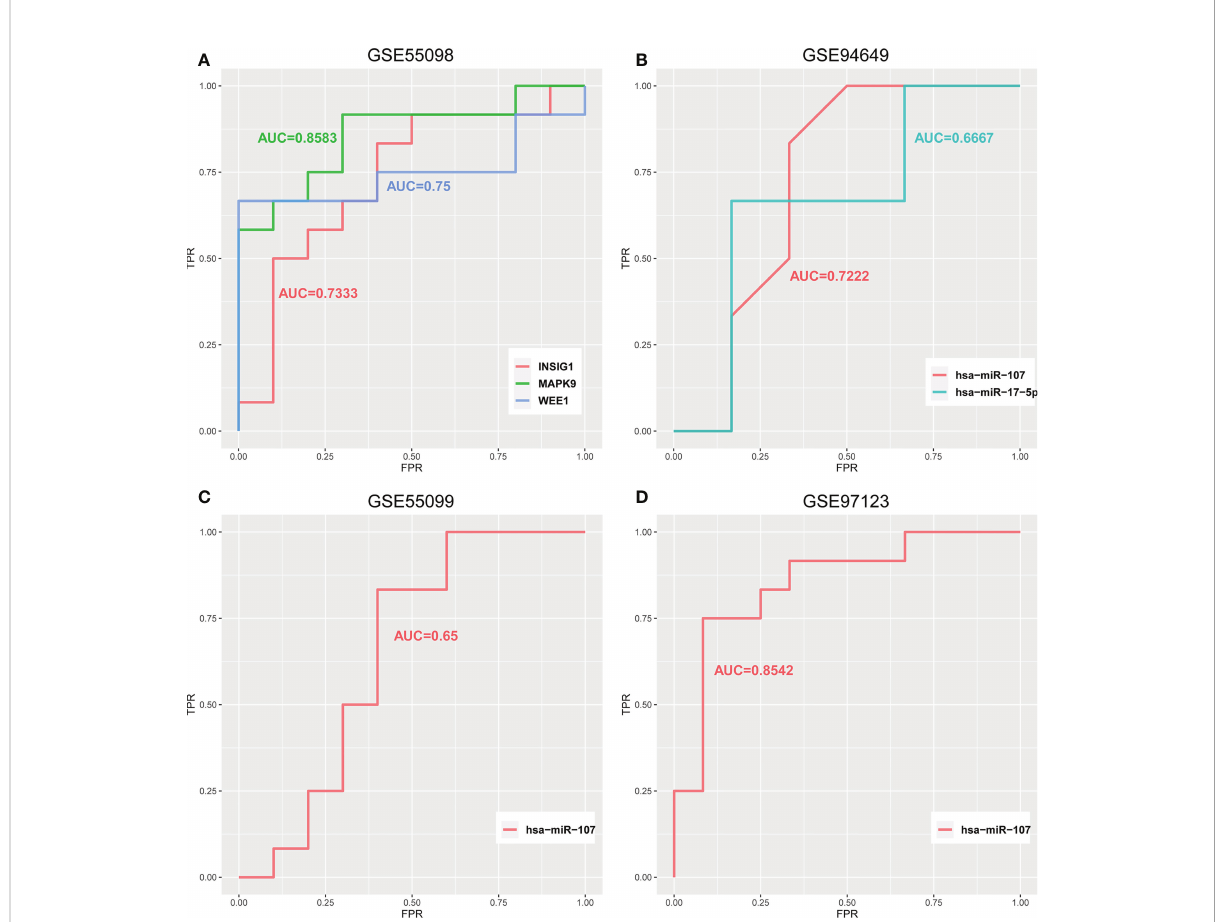
FIGURE 8 ROC curves for classifying type 1 diabetes samples of (A) GSE55098 based on the expression of LINC02086-hsa-miR-17-5p-MAPK9/WEE1 and LINC00960-hsa-miR-107-INSIG. (B) GSE94649 based on the expression of LINC02086-hsa-miR-17-5p-MAPK9/WEE1 and LINC00960-hsa- miR-107-INSIG1. (C) GSE55099 and (D) GSE97123 based on the expression of LINC00960-hsa-miR-107-INSIG1 regulatory